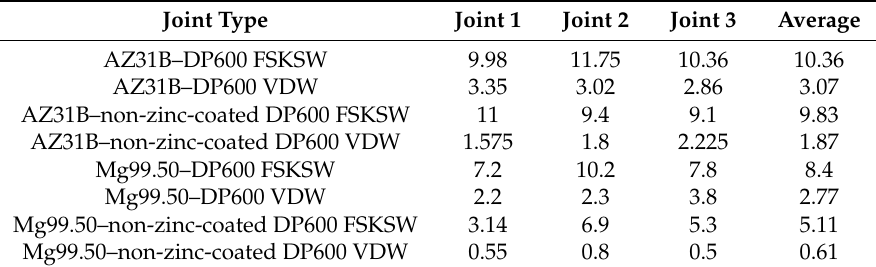
Table 3. Shear tensile properties of samples (kN).